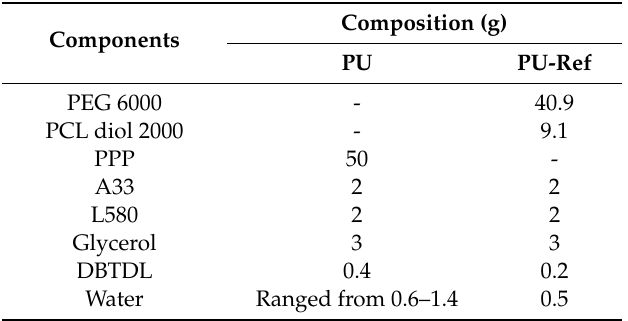
Table 2. Polyurethane formulation and PU-ref